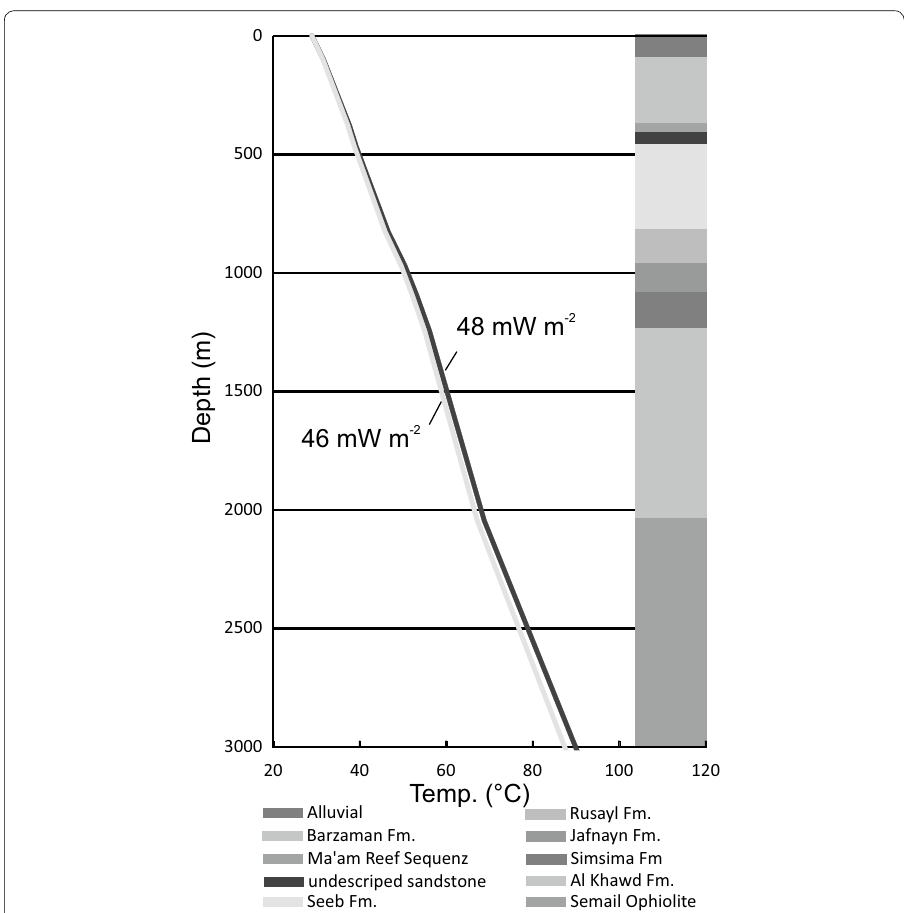
Fig. 6 Geotherms calculated for a heat flow of 46 and 48 mW m − 2 plotted next to stratigraphic information determined from Nolan et al.